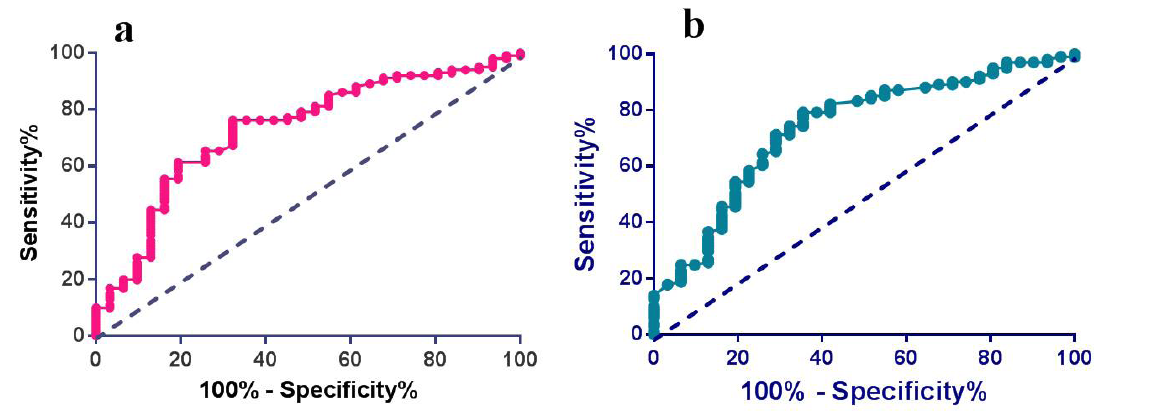
Figure 3: The ROC curve for serum Hcy and ESSEN score.